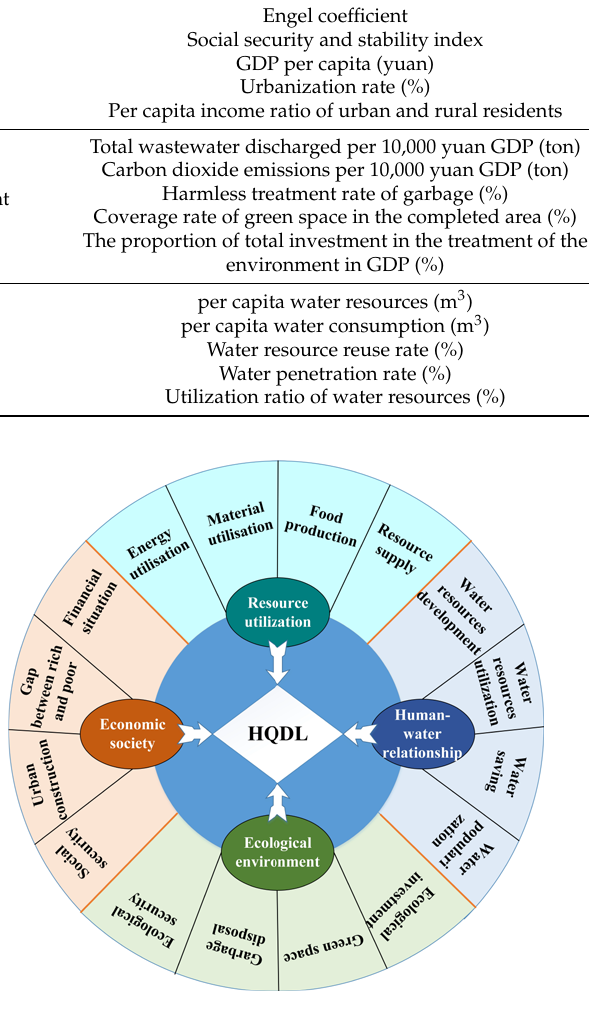
Figure 2. The connotation of index system construction. Table 1. Evaluation index system of HQDL considering water constraints (+ and − indicate positive and negative indicators respectively). Target Layer Subsystem Layer